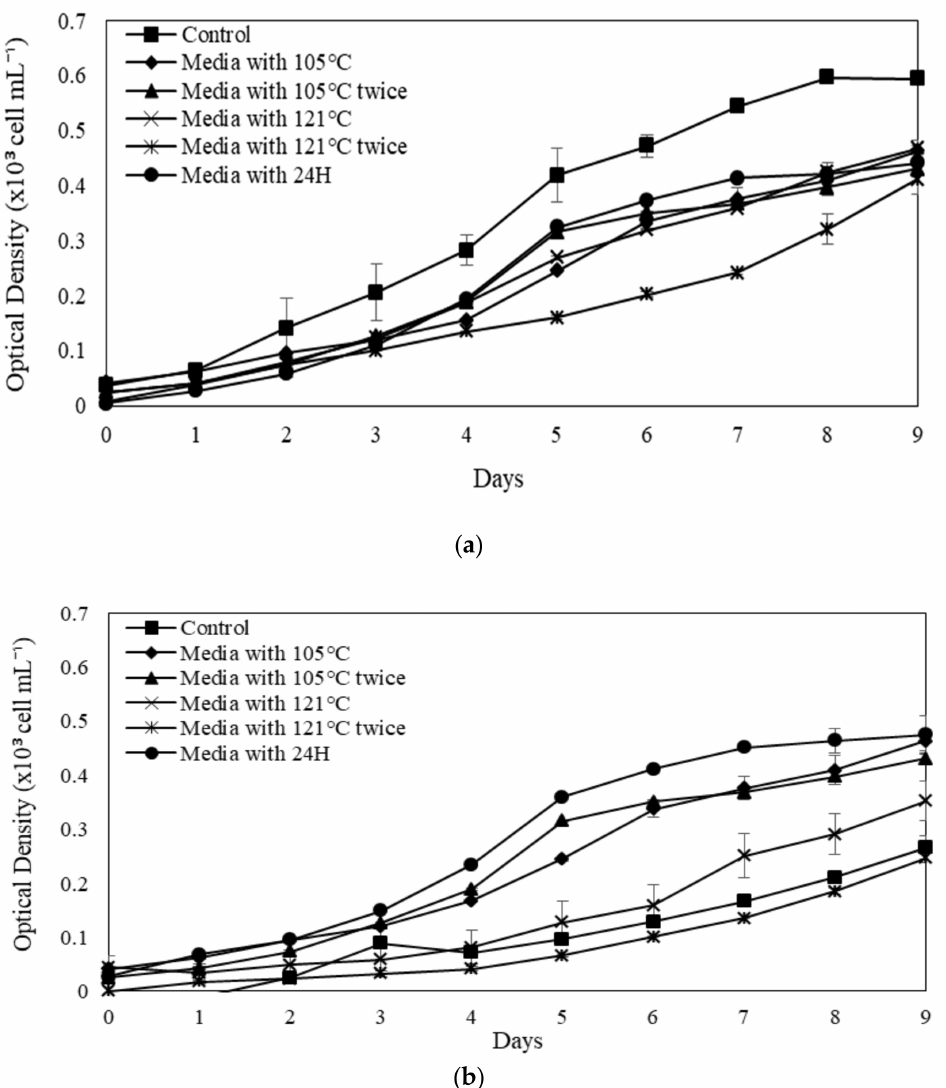
Figure 5. OD at 680 nm of N. subsolitaria in control (media without soil extract), media with 105 ◦ C, media with 105 ◦ C twice, media with 121 ◦ C, media with 121 ◦ C twice, and media with 24 h (media with 105 ◦ C—autoclave 105 ◦ C; media with 105 ◦ C twice—autoclave 105 ◦ C 2 × after natural extraction 24 h; media with 121 ◦ C—autoclave 121 ◦ C after natural extraction 24 h; media with 121 ◦ C × 2—autoclave 121 ◦ C twice after natural extraction 24 h; media with 24 h—natural extraction for 24 h). ( a ) RMFR SE and ( b ) AHFR SE. The error bars ( n = 3) indicating the standard